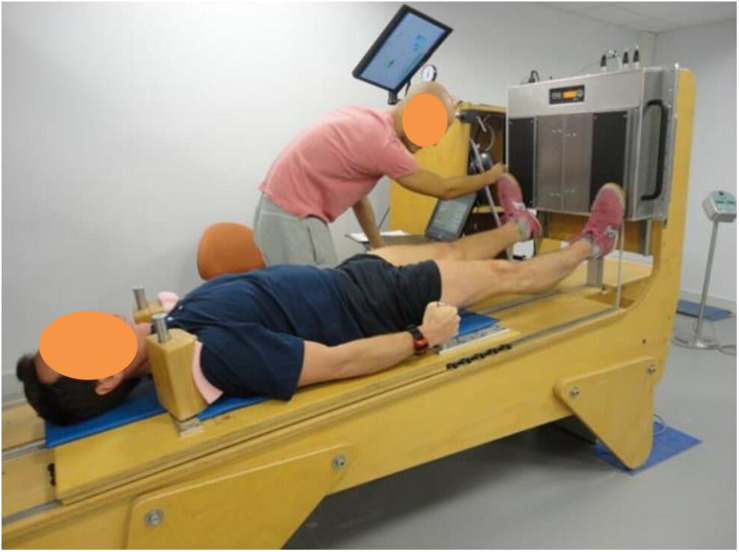
Resistive vibration exercise training (RVE and NeX groups): subjects performed all exercises in the head-down tilt position and were positioned on a moveable platform with shoulder pads and hand grips preventing downward movement and permitting application of force via the platform. A pneumatic system generated the force, applied through the moveable platform, against which the subject needed to resist and move (via the shoulder pads and hand grips). The feet were positioned on either side of a platform which was set to vibrate during high-load resistive exercises. Subjects were given visual feedback of their actual and target position in the exercise via a monitor placed in the subjects’ field of view. As the force output was dictated by the exercise device, the feedback focused on ensuring the subjects performing the exercise in the desired range of motion and at the desired speed. During the heel raises the sport scientist monitored the range of movement and encouraged the subject to go to the end of range in each direction. Here the subject is performing toe raises.